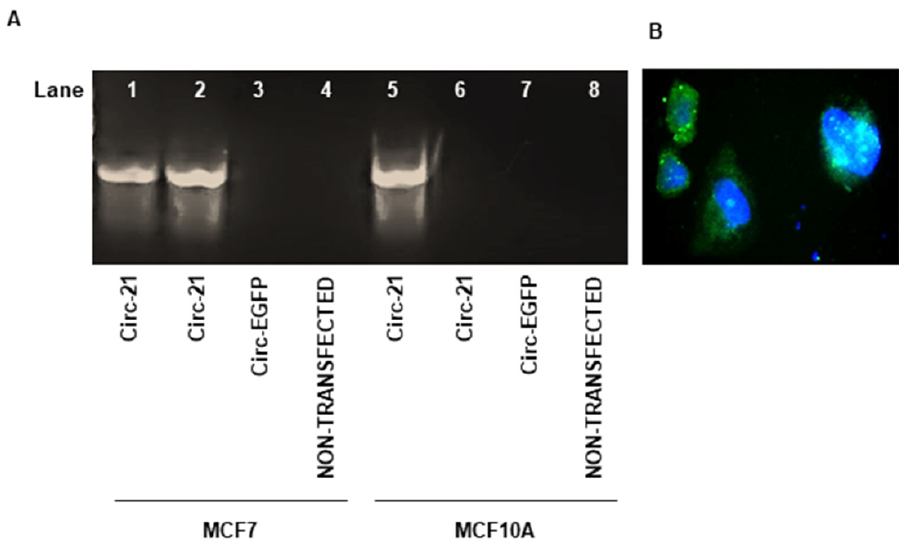
Figure 2. Expression of the Circ-21 by PCR (32 cycles). ( A ) Representative image of the PCR products. Lane 1, Circ-21 vector (positive control PCR); Lane 2 and 5, cells transfected with the Circ-21; Lane 3 and 7, cells transfected with the Circ-EGFP; Lane 4 and 8, non-transfected cells. The correct expression of miR-21 was confirmed in cells trasfected with the Circ-21. ( B ) Subcellular localization of the Circ-21. Representative microscopic image showing the detection of EGFP fluorescence (green) 72 h after transfection with the Circ-21 in MCF7. Cell nucleus were stained by DAPI (blue) (20 × ).